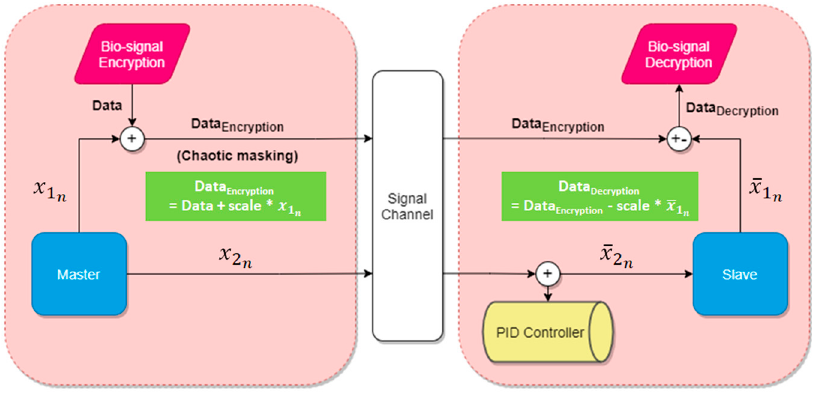
Figure 8. The secure biomedical system architecture.